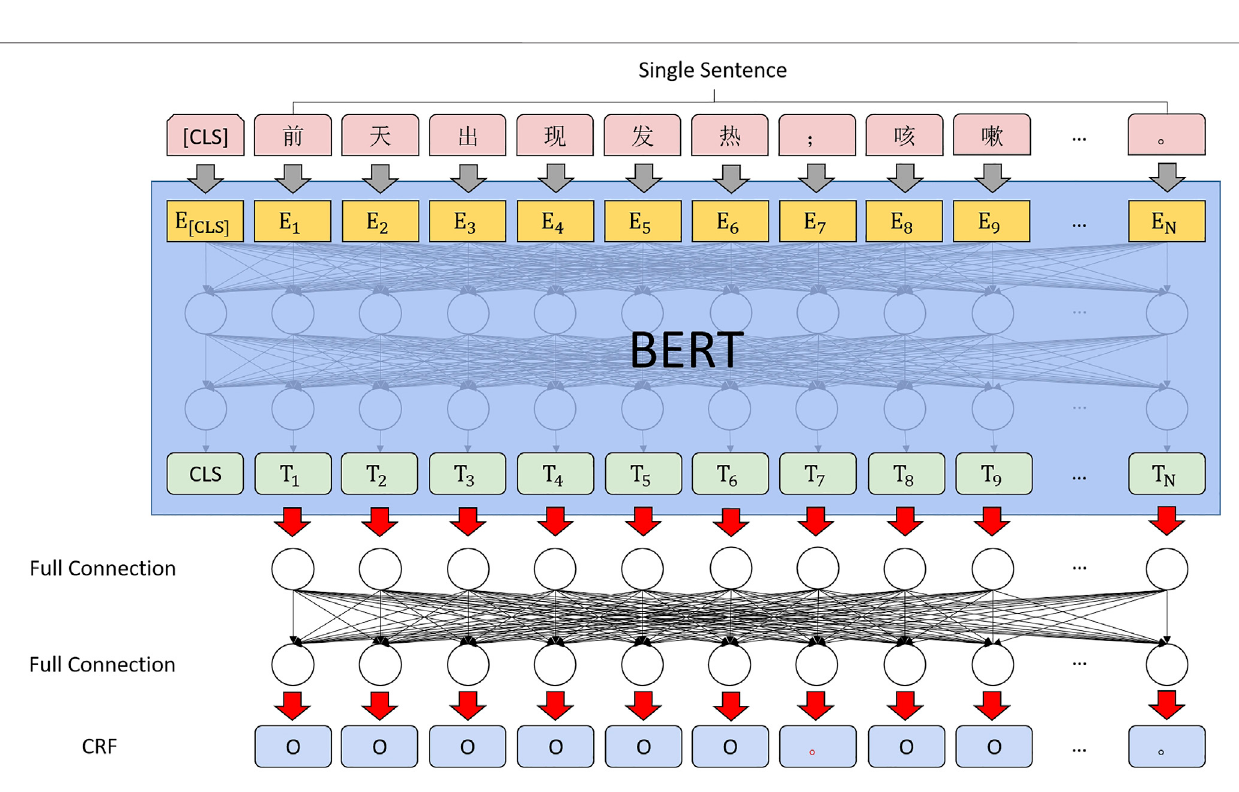
FIGURE 5 | Punctuation correction computing